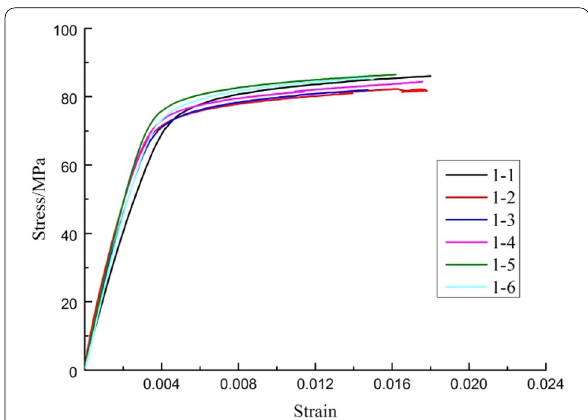
Fig. 5 Tensile stress–strain relationship of the